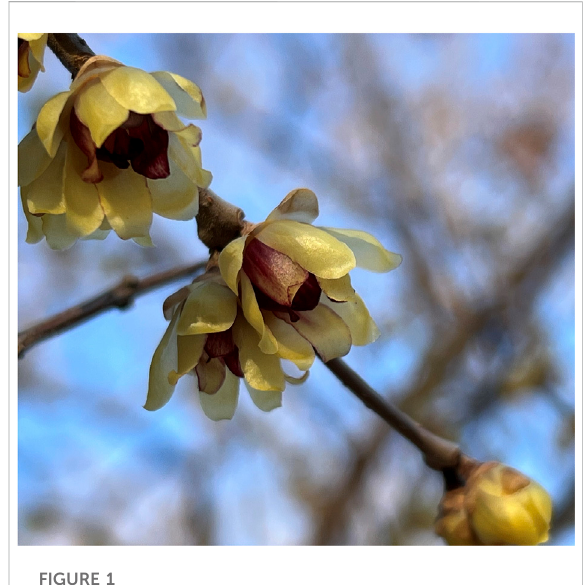
FIGURE 1 The fresh fl owers of Chimonanthus praecox (L.)